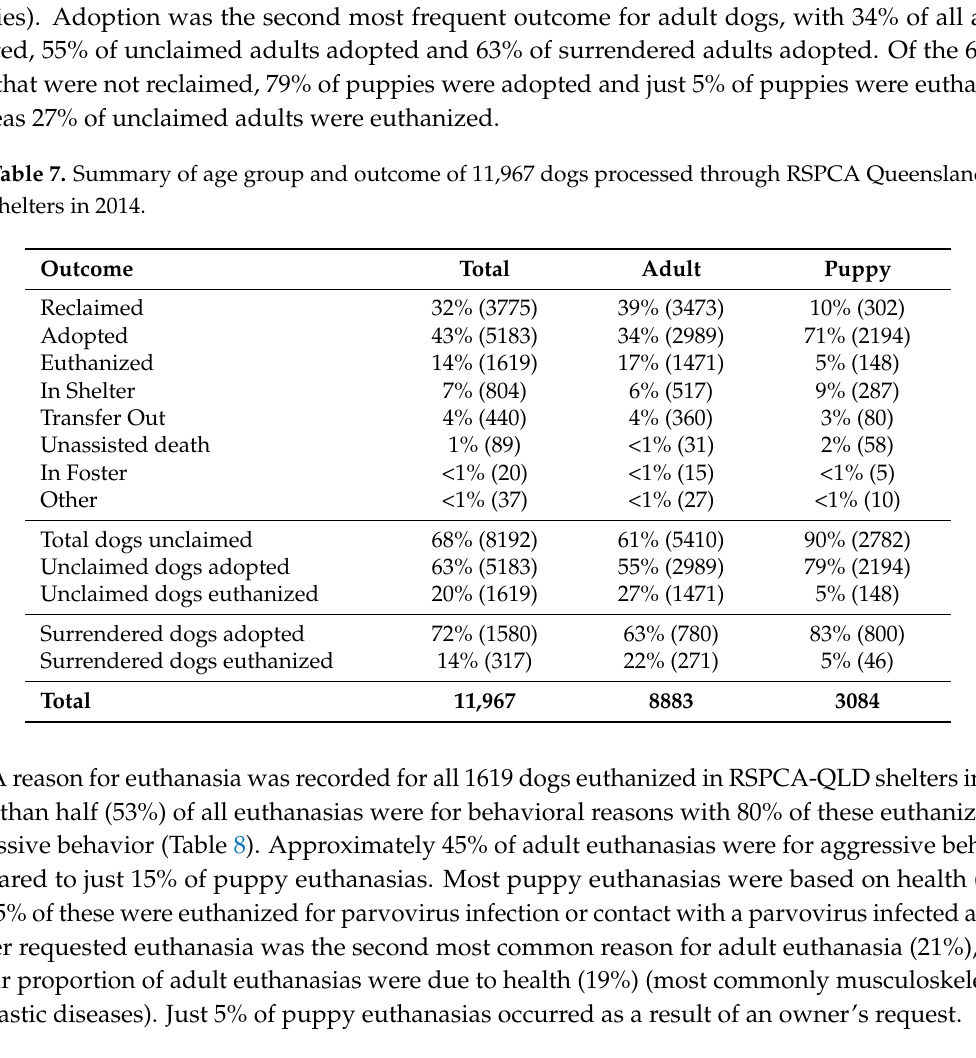
Table 8. Reasons for euthanasia for 1619 dogs euthanized in RSPCA-QLD shelters in 2014. Euthanasia Reason